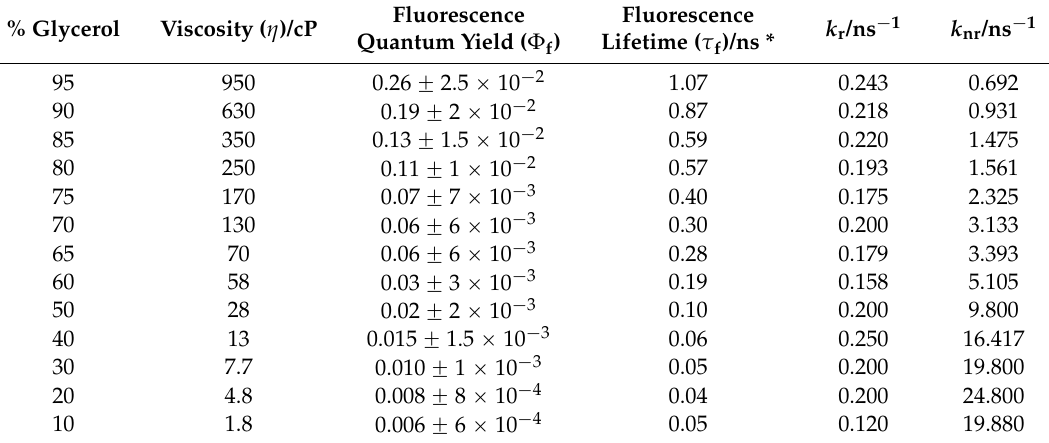
estimates only. Lifetimes are ± 0.10 ns.